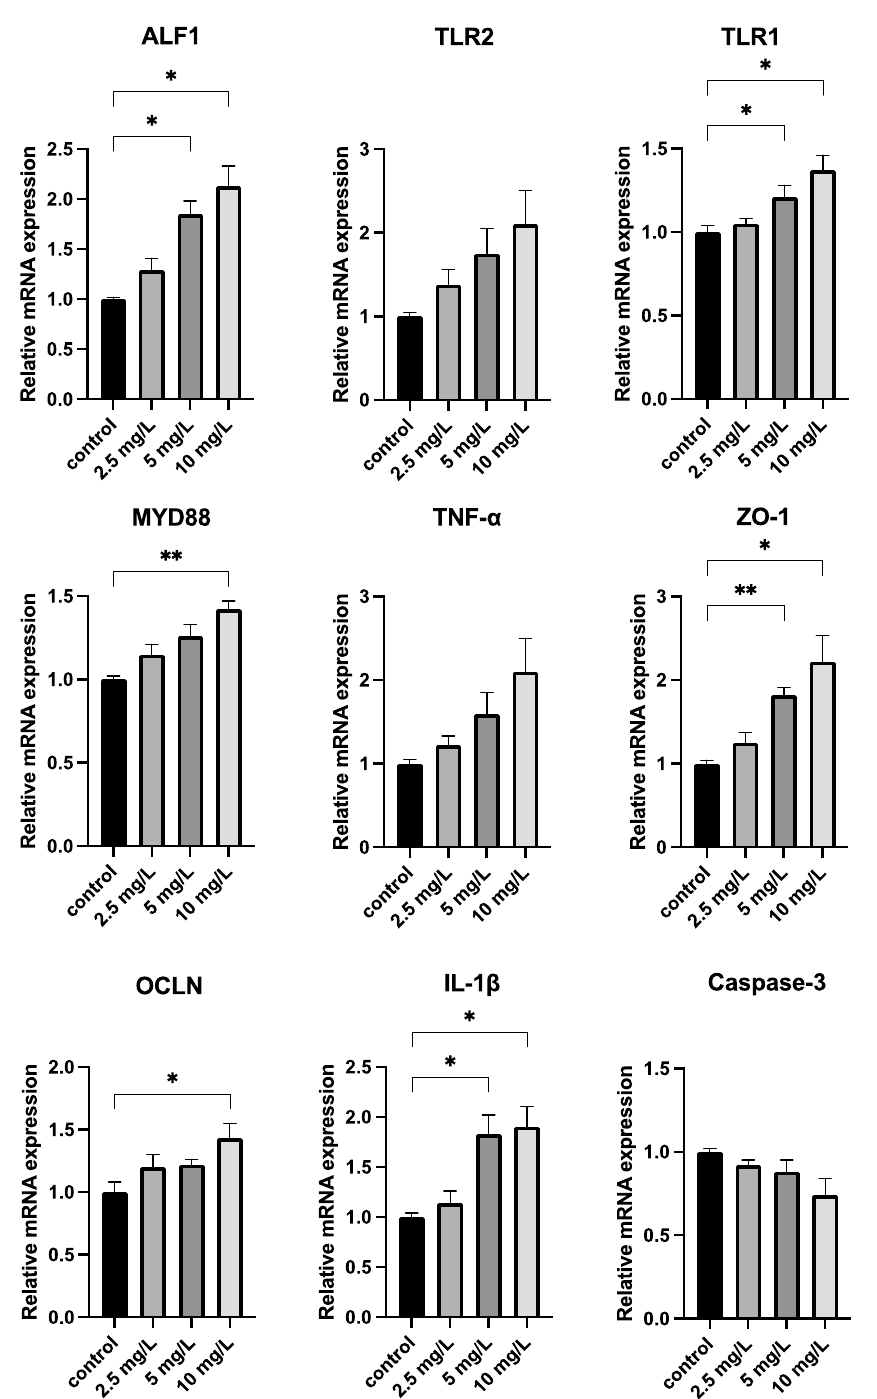
Figure 5. Levels of mRNA in the genes associated with the immune response in the liver of O. potamophila after exposure to quercetin. Values are given as mean ± SD ( n = 3). “*” indicates p < 0.05 compared to the control; “**” indicates p < 0.01 compared to the CK.